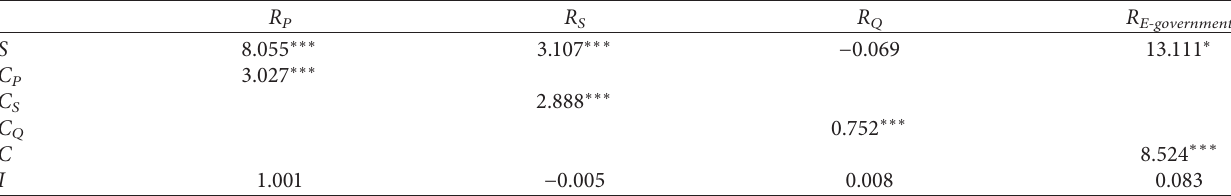
Table 6: Regression analysis of influencing factors of E-GR in